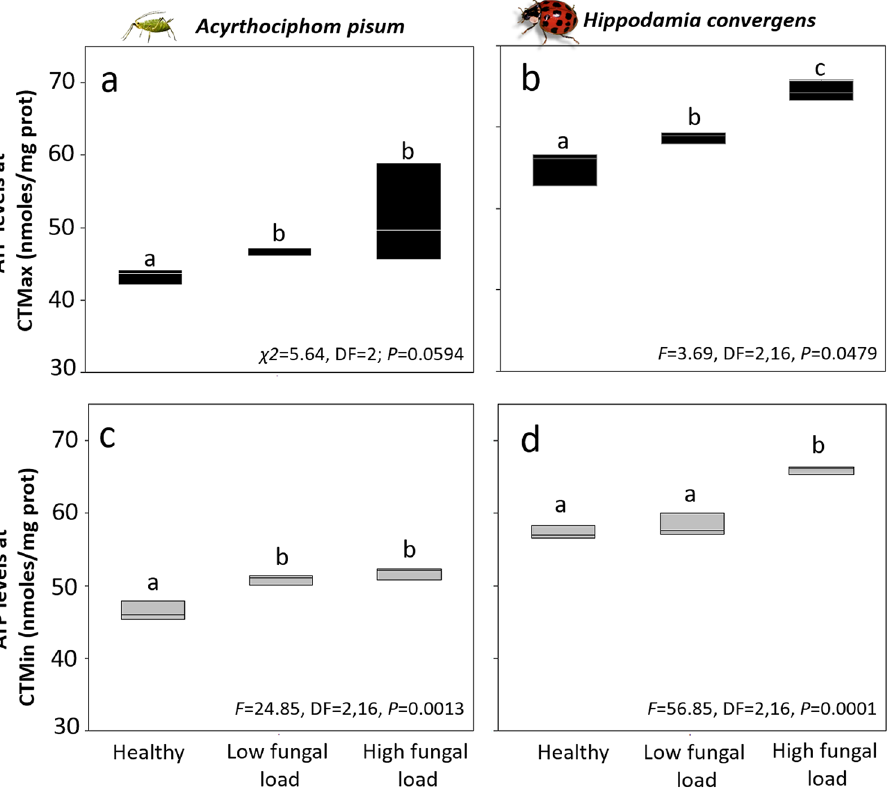
Figure 3. ATP levels of healthy and infected aphid and predator beetle species at upper and lower thermal tolerance (CT Max or CT Min ). Infections: Low spore load = 1.4 × 10 6 spores ha −1 , high spore load = 1.4 × 10 12 spores ha −1 . Box plots display median line, interquartile range (IQR) boxes, 1.5 × IQR ( n = 3 individuals per treatment). Black boxes: CT Max ; gray boxes: CT Min . Significance was determined by ANOVAs and non-parametric ANOVAs (Kruskal–Wallis) followed by post-hoc tests, letters represent differences within treatments ( α =